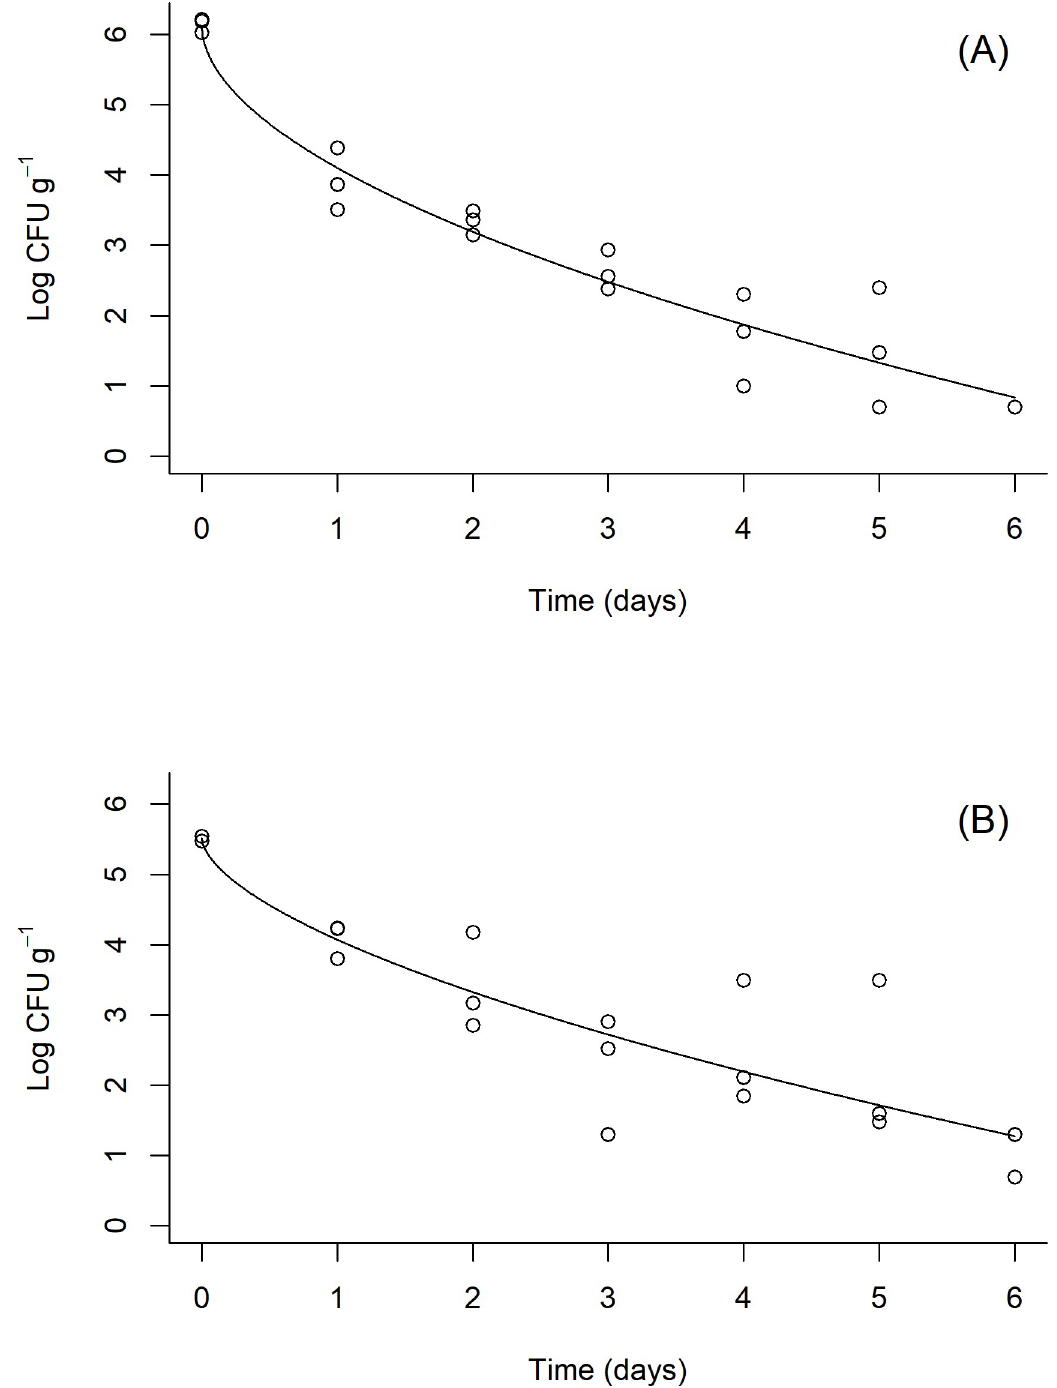
Fig 2. Salmonella Typhimurium (ST) survival fitted by Weibull models for irradiated (A) and natural (B) litter microcosm data. Datapoints (˚) for each sampling time (n = 3) and Weibull model curve are shown.